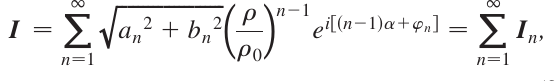
FIG. 5. Circular 4PCTs with two radii: (cid:2) = 2 (cid:2) 0